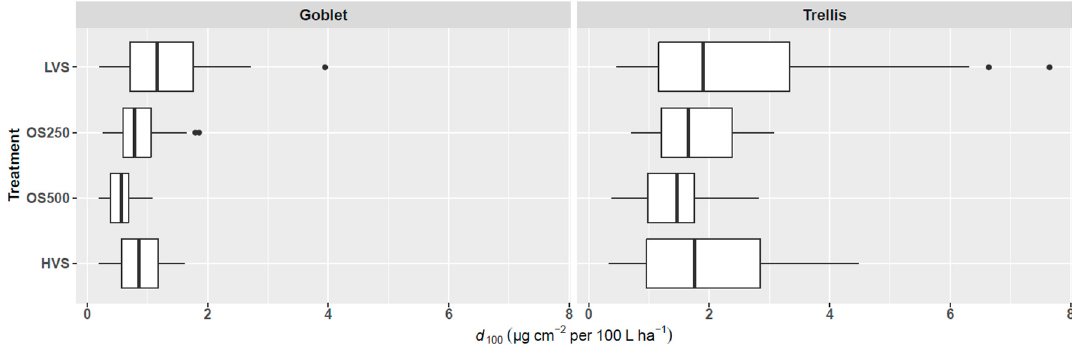
Figure 7. Normalized deposition ( μ g cm − 2 ) per 100 L of spray liquid per ha ( d 100 ) for the four different sprayers for the goblet and trellis training systems. Boxplots show the median for each treatment, box boundaries show the 25th and 50th percentile, while whiskers extend to 1.5 times the interquartile range (IQR). Points beyond 1.5 times the IQR are plotted individually.